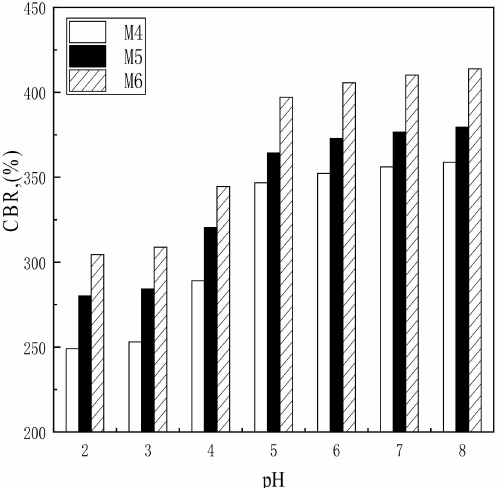
Figure 3. CBR value of cement–PG-stabilized soil as a function of the PG pH